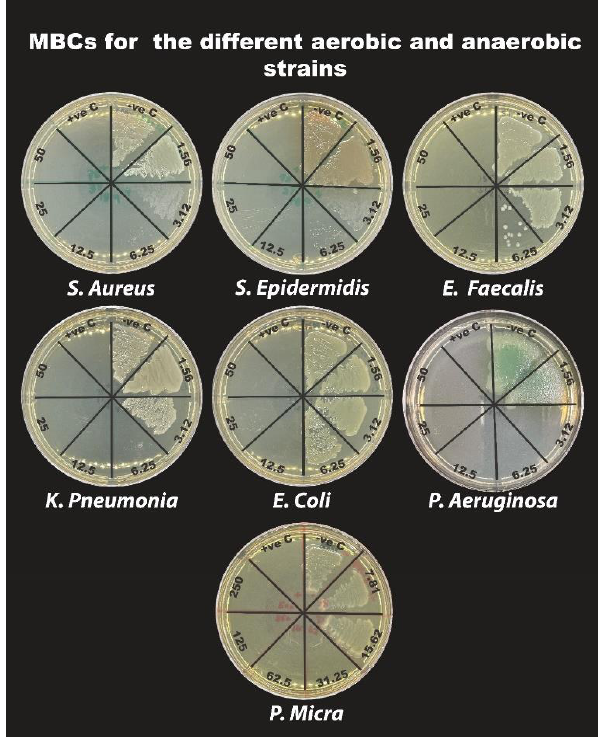
Figure 4. MBCs of C-CaOH 2 NPs on the tested pathogens. In a counter clock-wise direction: +ve C: positive control; 50 – 1.56 and 250 – 7.81: C-CaOH 2 NPs concentrations; and − ve C: negative control.